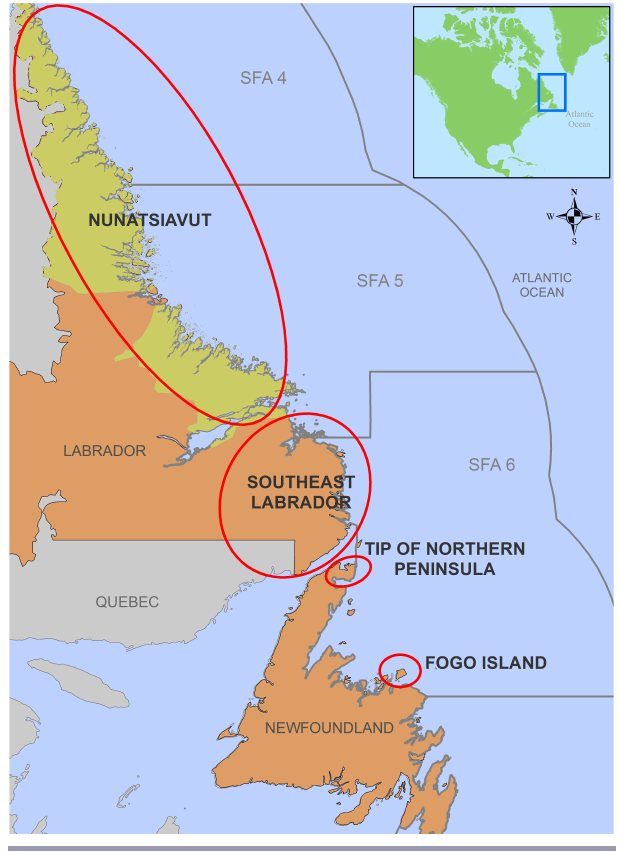
Fig. 1. Map indicating the locations of the case study regions within the province of Newfoundland and Labrador,